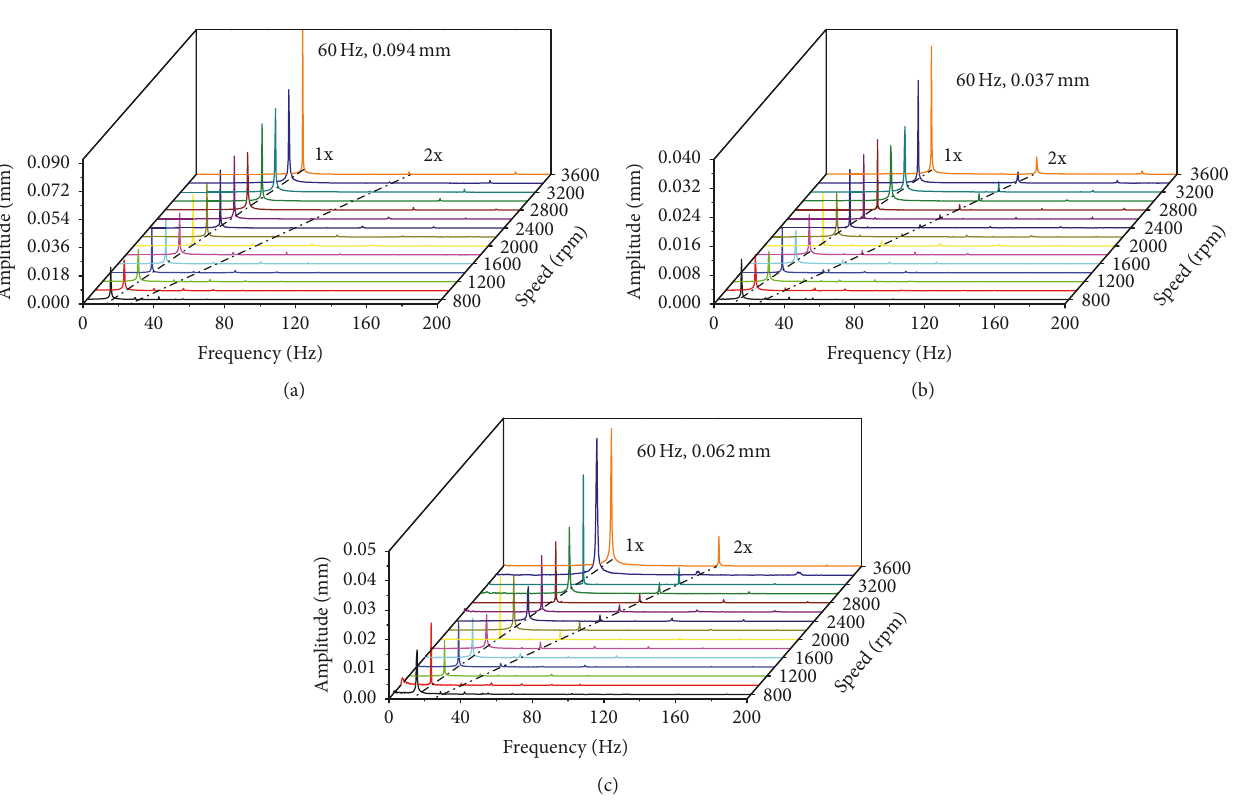
Figure 8: Comparison of waterfall plots: (a) 0–90 ∘ partial distribution; (b) 0–160 ∘ partial distribution; (c) 0–160 ∘ full distribution.